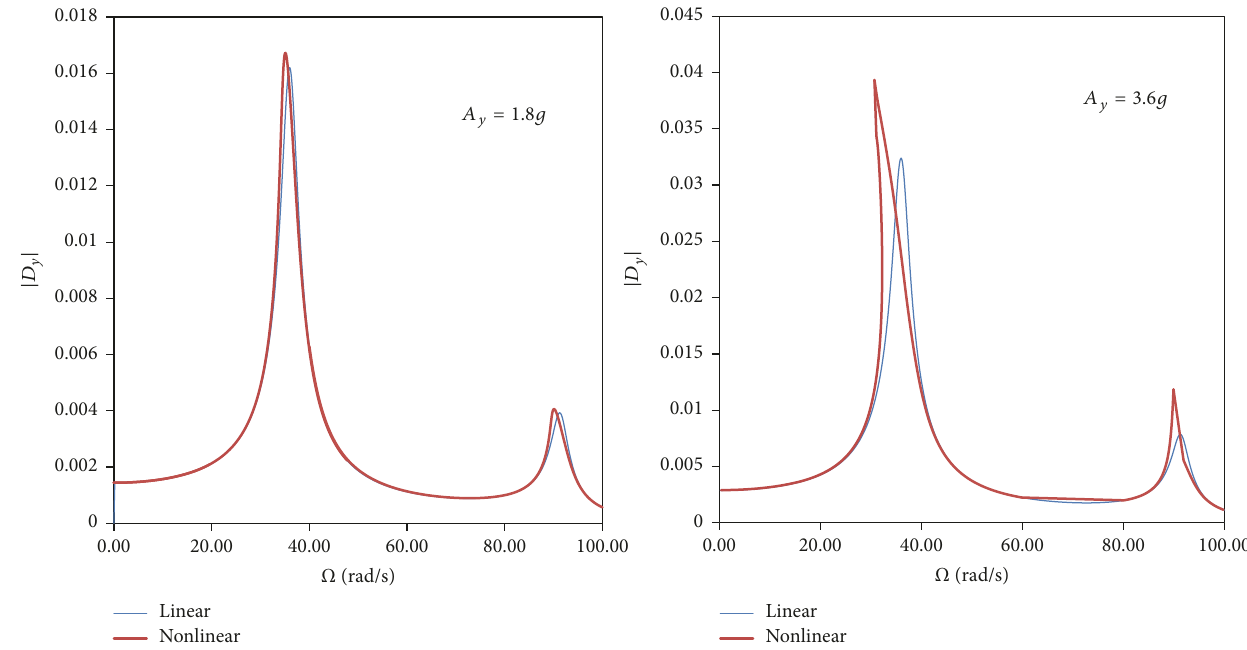
Figure 15: Influence of increasing base motion 𝐴 𝑥 on the nonlinear response of the frame under vertical excitation. Norm of the vertical displacement at top of pitched roof as a function of the forcing frequency. 𝐿 = 10 m and 𝐻 = 6 m.